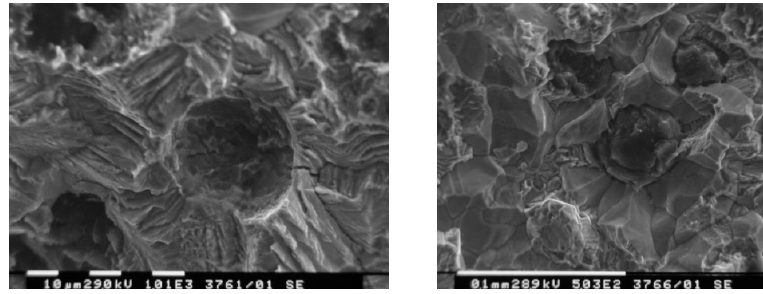
Figure 34: Ferritic DCI (R = 0.1,  K = 12 MPa √ m).